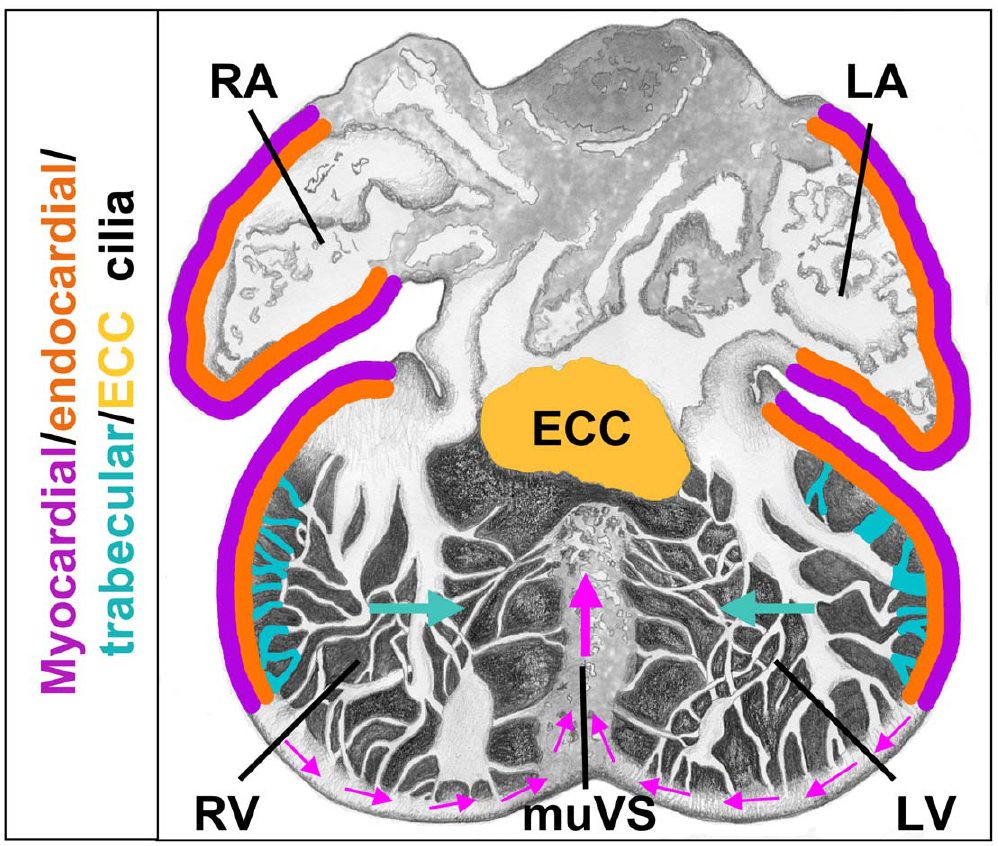
Figure 9. Model of VS development. Myocardial (violett), endocardial (orange) and most likely trabecular cilia (turquoise) regulate proliferation at distinct cardiac regions. In the ventricles, the cell proliferation in these regions results in wall thickness control, trabecular formation and a push of cells toward the base of the muscular ventricular septum (indicated by pink arrows). ECC cilia (yellow) seem to be different from the other cardiac cilia, since they do not regulate ECC proliferation. LA, left atrium; RA, right atrium; LV, left ventricle; RV, right ventricle; muVS, muscular ventricular septum.